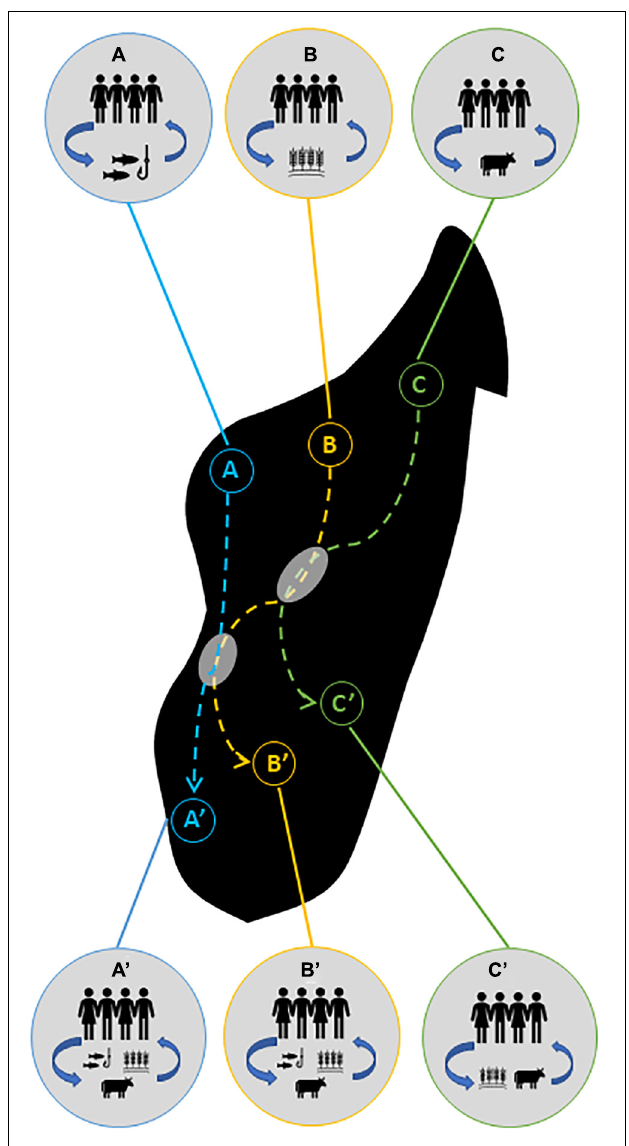
FIGURE 3 | Illustration of perturbation and relocation components of Niche Construction Theory (NCT). Each population (A–C) performs specific activities which create feedbacks (blue arrows) between themselves and their surrounding environments. This constitutes a cultural “niche.” Relocation is represented by the dashed arrows, in which people move throughout a landscape and take their practices with them. In addition, ideas and adaptations can be spread from one community to another (gray circles) when different groups overlap in time and space, leading to the adoption of new behaviors and the formation of new niches (A’–C’)